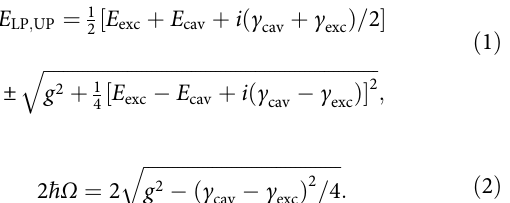
device at 10 K. The energy-momentum mode structures are measured via angle-resolved micro-re fl ectance (Fig. 2a, b) and micro-PL (Fig. 2c) spectroscopy, in both the along-bar (top row) and across-bar (bottom row) directions. The data (left panels) are compared with numerical simulations (right panels), done with rigorous coupled wave analysis (RCWA).